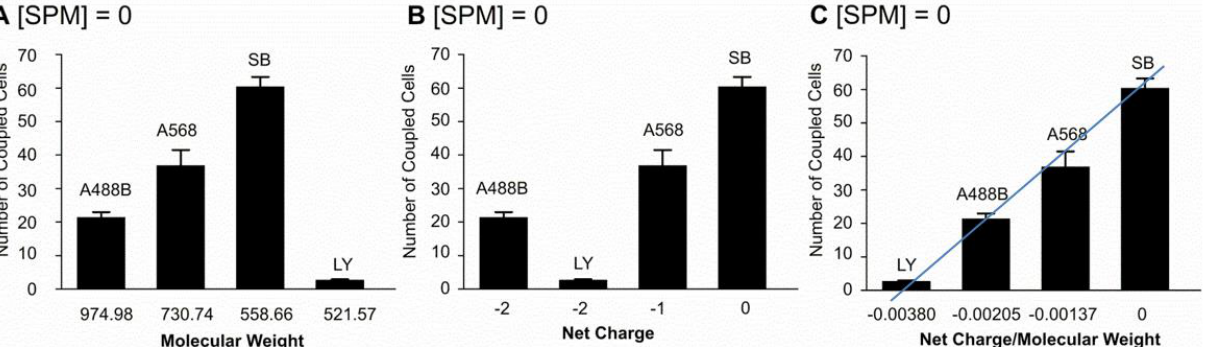
Figure 4. Comparison of astrocyte-to-astrocyte coupling in the control group (in the absence of spermine ([SPM] = 0 in the intracellular solution)) and their dependence on the characteristics of the individual dyes. ( A – C ): The number of coupled cells in the Alexa 488- biocytin group (A488B, 21.4 ± 1.6, N = 11, Vm = −79.7 ± 1.4 mV), Al exa 568 (A568, 36.9 ± 4.6 cells; Vm = −80 ± 0.8 mV, N = 10), Sulforhodamine B (SB, 60.4 ± 2.9, N = 7, Vm = −79.4 ± 1.1 mV) and Lucifer Yellow (LY, 2.7 ± 0.2, N = 15, Vm = −80.2 ± 0.7 mV) is dependent on ( A ) molecular weight of the dye, ( B ) net charge of the dye and correlates ( C ) with the ratio of net charge and molecular weight of the dye. Error bars indicate standard error of mean